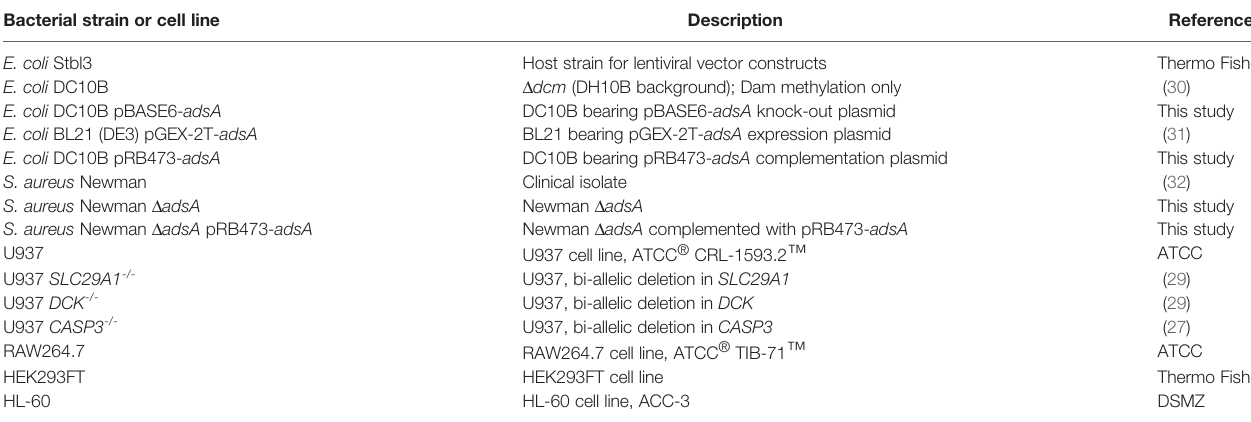
TABLE 1 | Bacterial strains and cell lines used in this study.